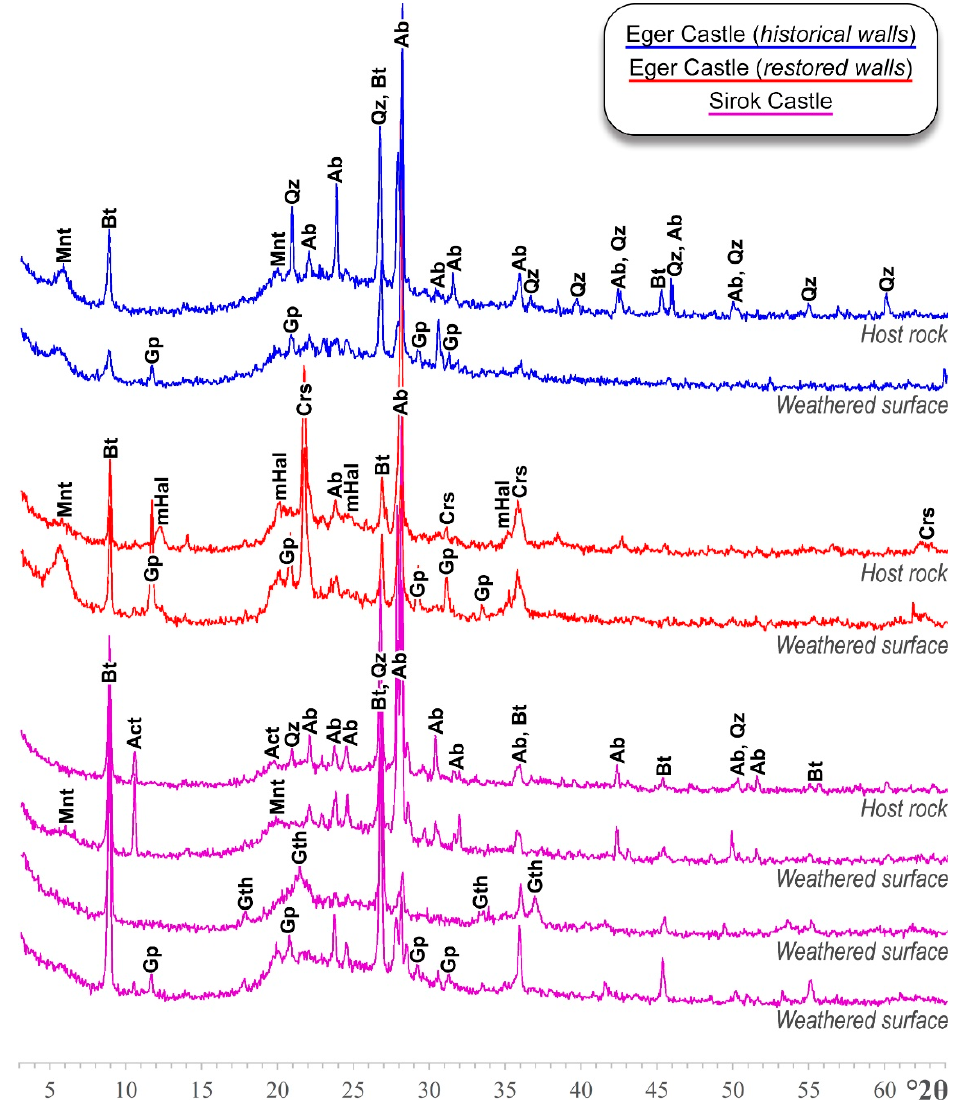
Figure 5. Powder XRD patterns indicating the mineralogical composition of the studied tuffs and the extra phases detected on their weathered surfaces (Ab = albite; Act = actinolite; Bt = biotite; Crs = cristobalite; Gp = gypsum; Gth = goethite; mHal = meta-halloysite; Mnt = montmorillonite; Qz = quartz).